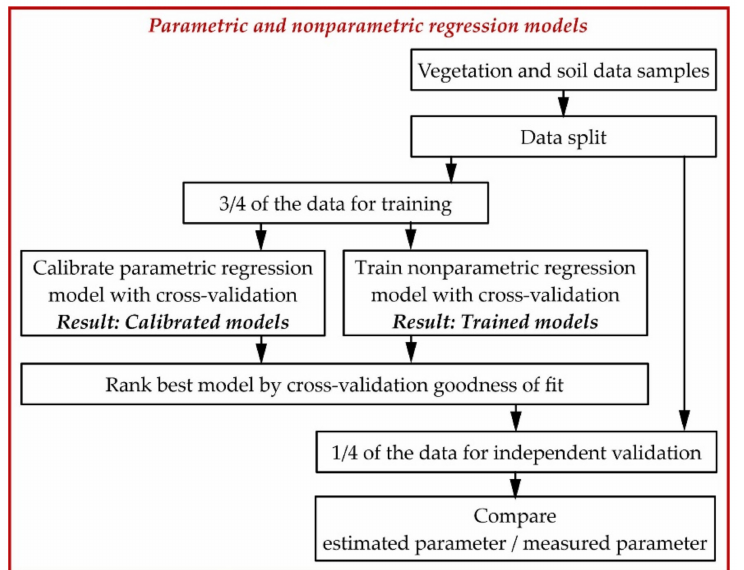
Figure 3. Workflow diagram of the parametric and nonparametric regression